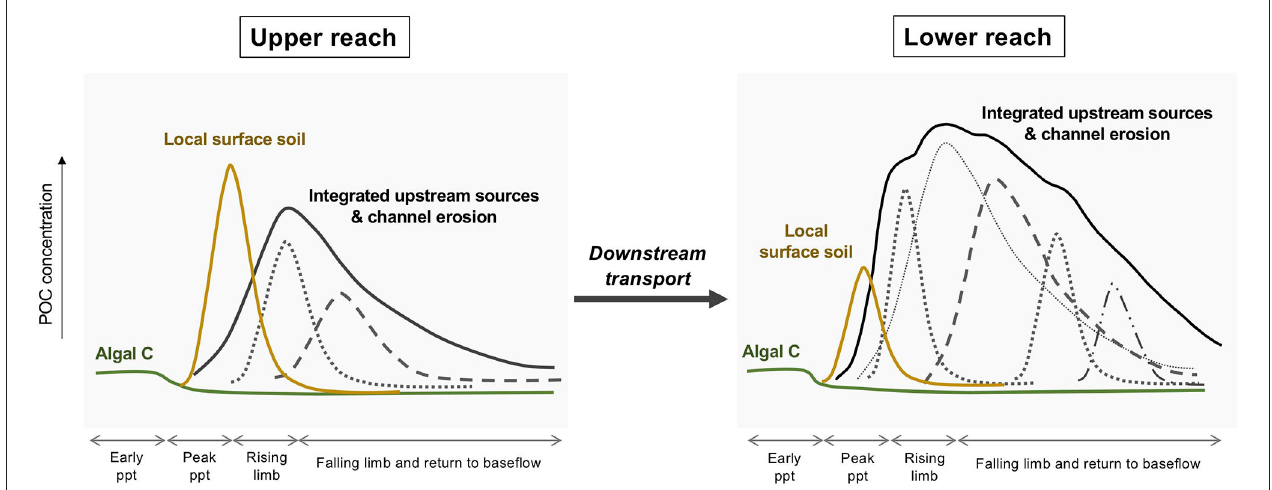
FIGURE 9 | Conceptual response of a small agricultural stream to a storm event in terms of sources of POC. During early ppt periods during the summer-early fall, algal growth dominates the POC pool. Heavy precipitation erodes surface soils from row crop fields, especially after harvest, and this material is delivered to the channel most efficiently in the upper reach. The dominant POC pool is a complex mixture that is an integration of upstream sources including bank erosion. Individual peaks under the larger umbrella curves represent hypothetical constituent sources that arrive at different